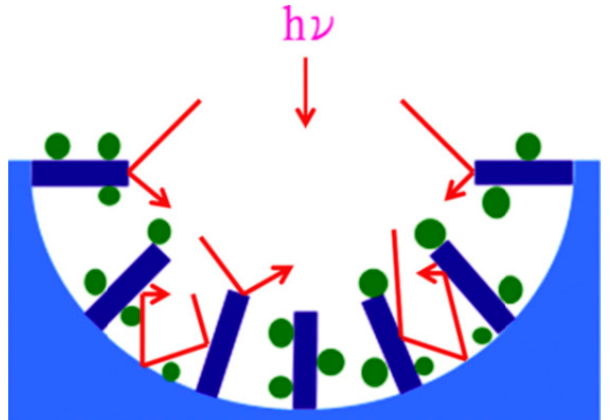
Figure 9. Schematic illustration of interface scattering due to nanograss decorated pore-array photocatalysts. Figure adapted from [116].